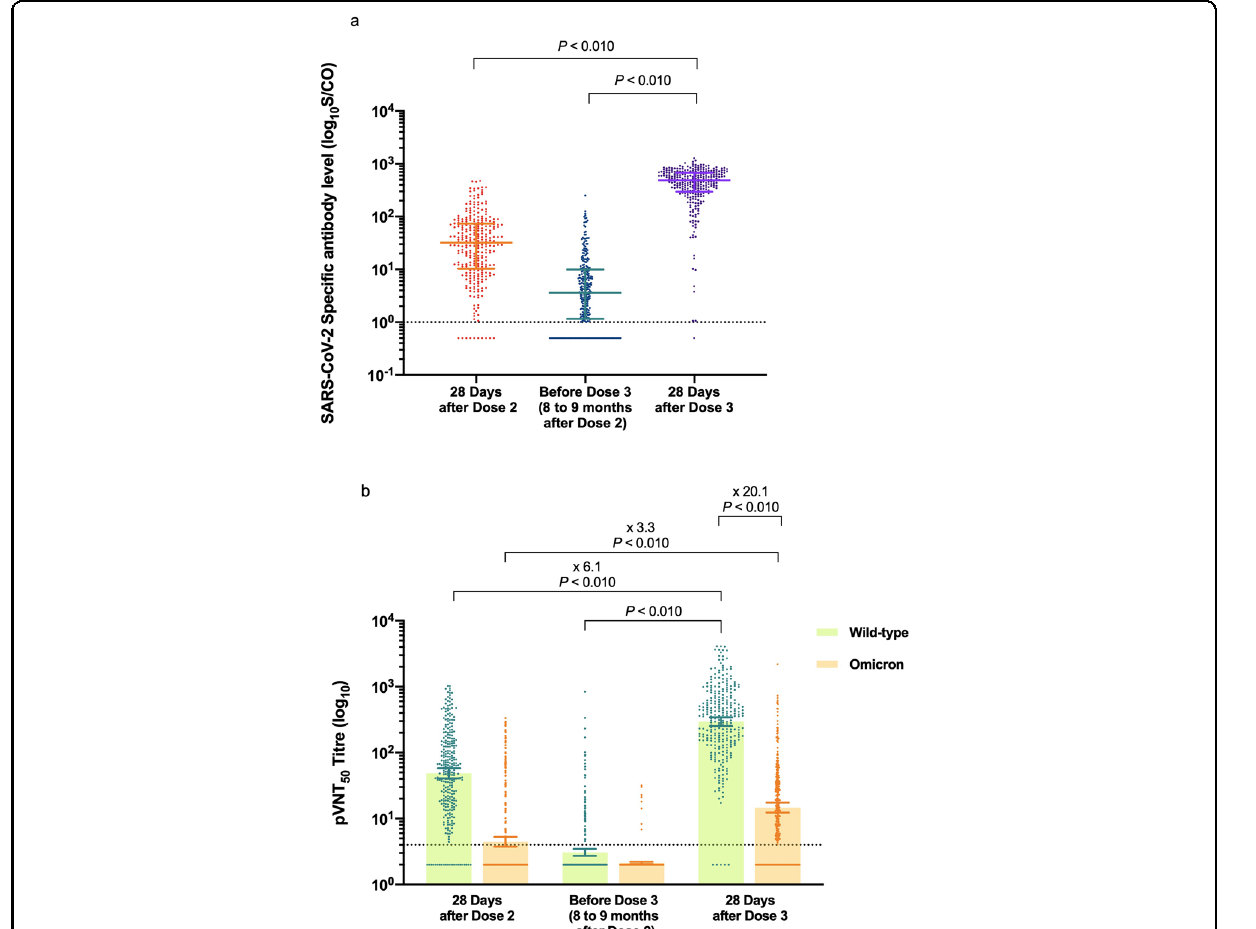
Fig. 1 Anti-SARS-CoV-2-speci fi c antibody and neutralizing antibody responses in serum samples of the 292 participants. a The speci fi c antibody levels against SARS-CoV-2 at different time points are shown. The horizontal dashed line represents the lower limit of detection (LLD) of 1. Results below the LLD were set to 0.5 times the LLD. Data points shown on the bar graph represent individual titers. Error bars indicate median and interquartile range (IQR). b Results of 50% pseudovirus neutralization titer (pVNT50) against the WT strain and the Omicron variant at the time points are shown. The horizontal dashed line represents the lower limit of detection (LLD) of 4. Results below the LLD were set to 0.5 times the LLD. Data points shown on the bar graph represent individual titers. Error bars represent the geometric mean with the 95% con fi dence interval (95% CI). Fold- changes in geometric mean titer are shown above. P values were calculated using the Wilcoxon matched-pairs signed-rank